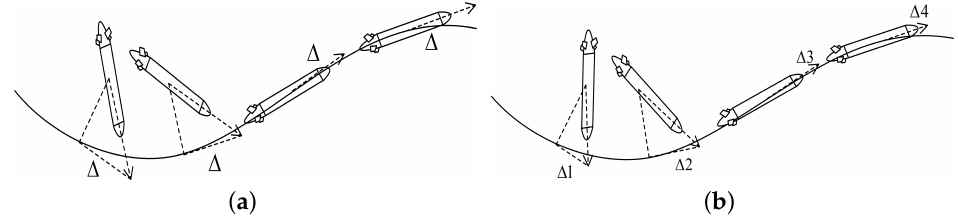
Figure 6. Variable curvature curve tracking. ( a ) Constant ∆ ; ( b ) Adaptive ∆